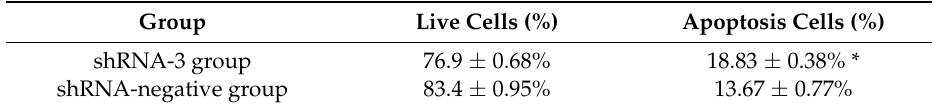
Table 1. Effects of XBP1 silencing on granulosa cell apoptosis.